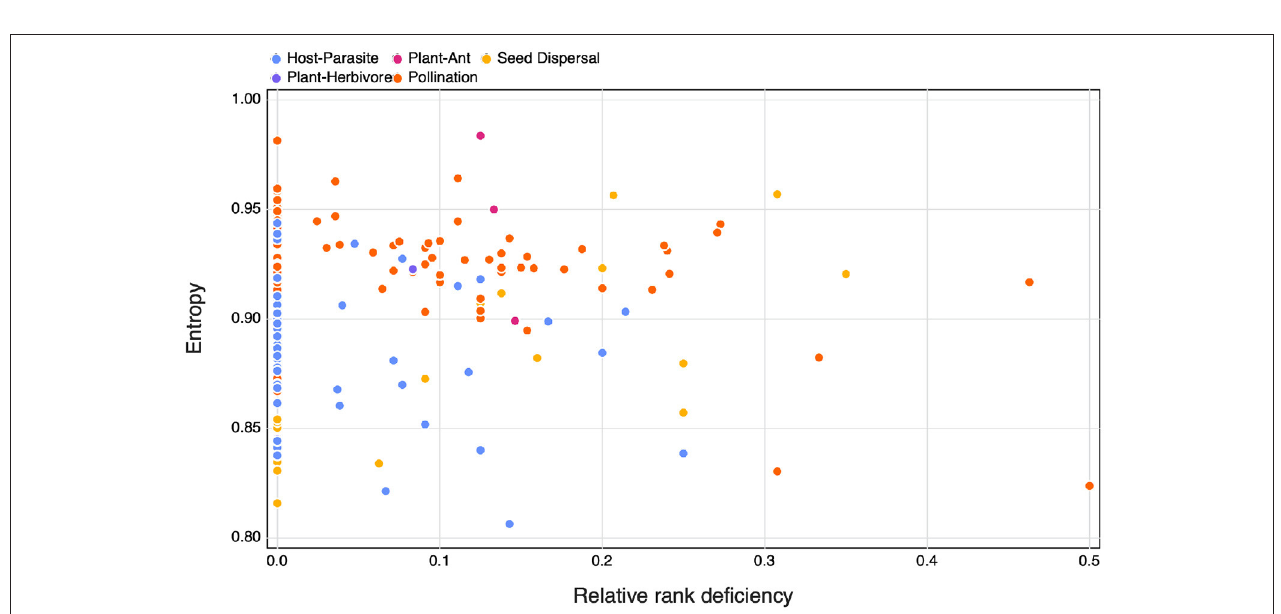
FIGURE 1 | The relationship between network richness and relative rank deficiency, and SVD entropy. The different types of interactions are indicated by the colours.